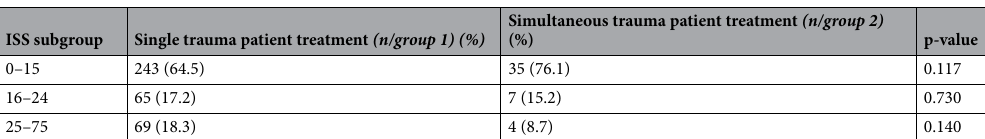
Table 3. Distribution in the three ISS subgroups (0–15 = minor trauma; 16–24 = moderate trauma; 25–75 = severe trauma).